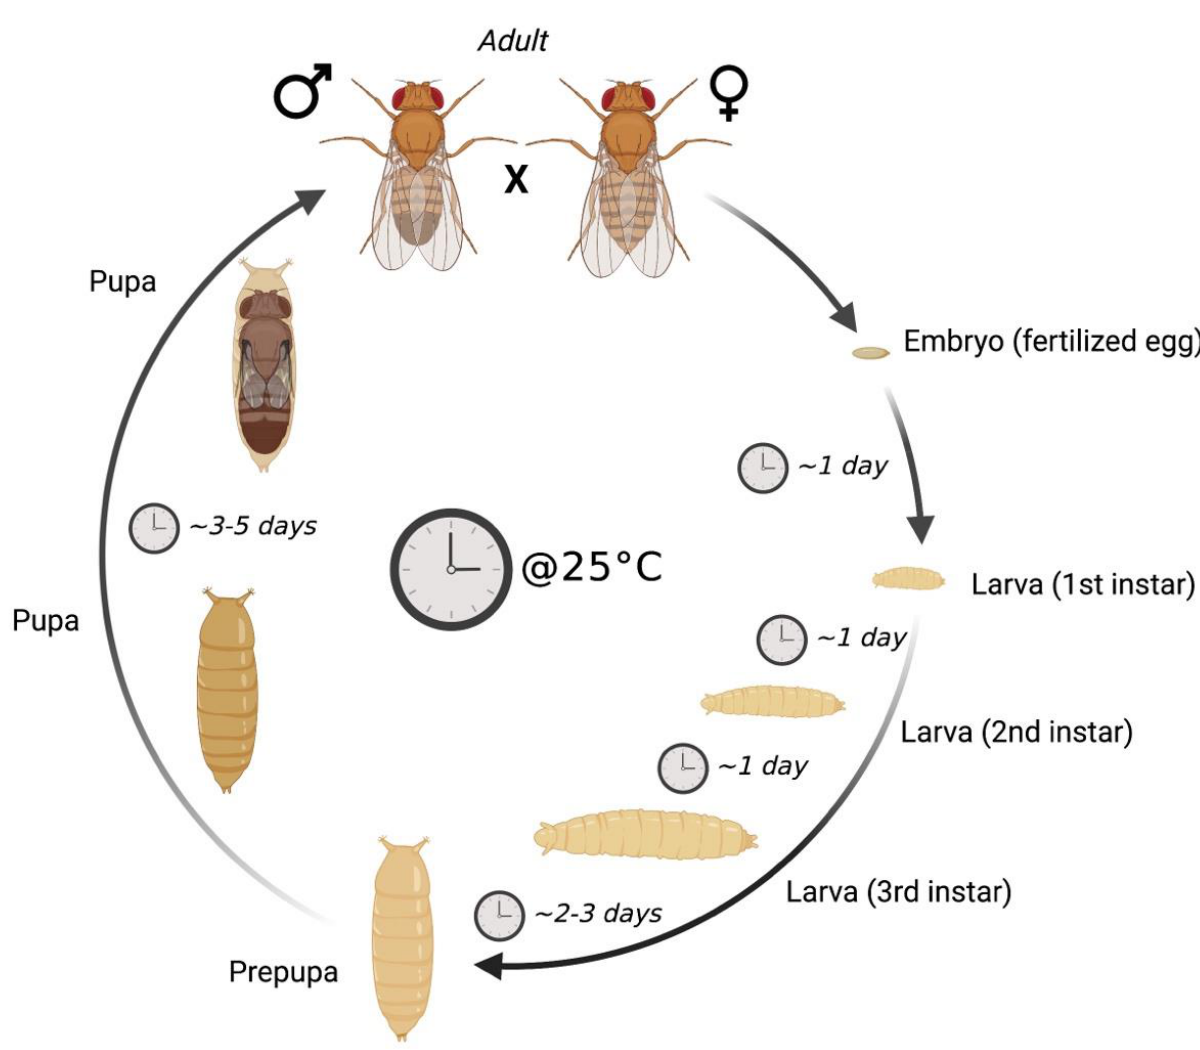
Figure 1. D. melanogaster life cycle at 25 °C. After mating between adult female and male flies, fertilized eggs are laid and the embryo develops into a first instar larva in ~24 h. Afterwards, the larvae grow and go through two additional larval stages (second and third instars), each one lasting ~24 h. During the larval stages, D. melanogaster exhibits high glycolytic flux, lactate production, and a high rate of glycogen synthesis and triglyceride (TAG) accumulation, which are needed for the metamorphosis. At the end of the third instar (2–3 days), larvae pupate. During the pupal stage, metamorphosis occurs (3–5 days) and adult fly tissues form. At the end of the metamorphosis, eclosion from the puparium occurs and adult flies become fertile after ~24 h. Flies live for 60–90 days depending on the rearing conditions (i.e., temperature and diet composition).